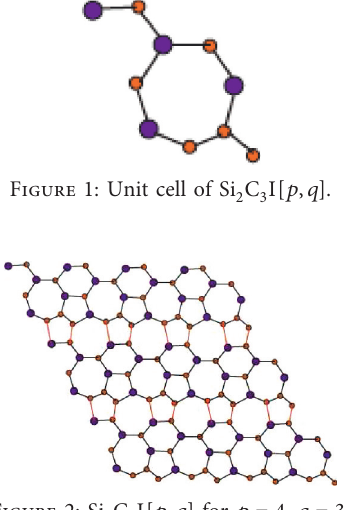
C I [ p,q ] for p � 4, q � 3. 2 3